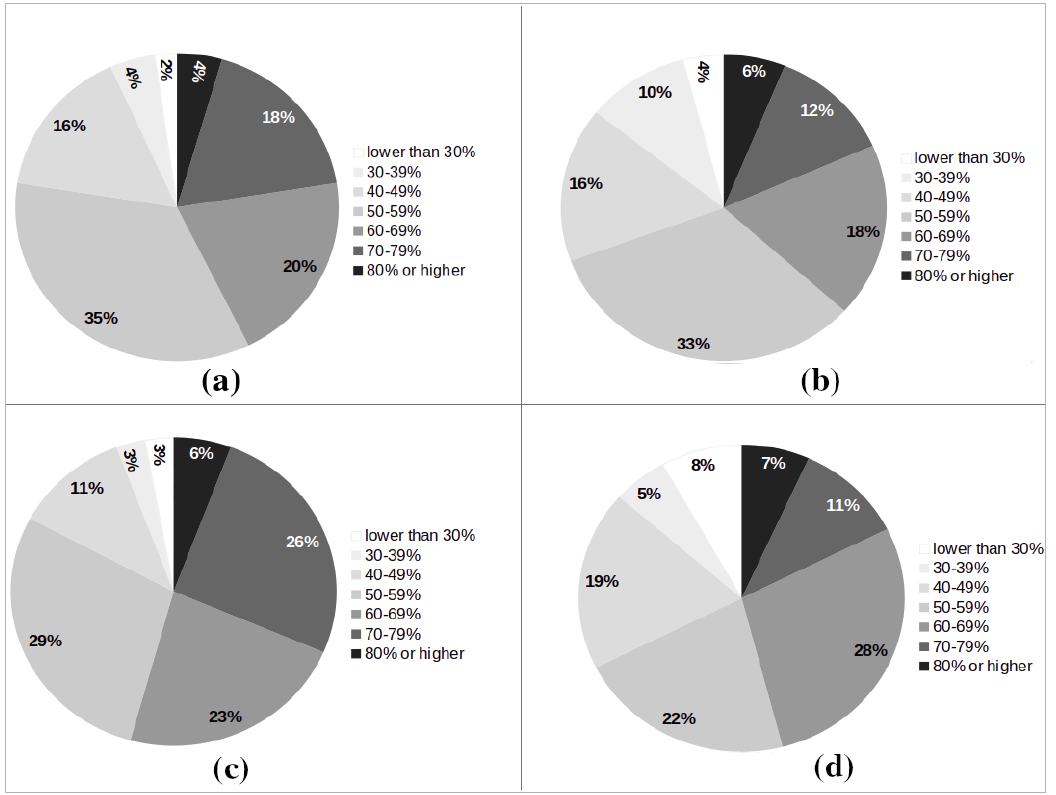
Figure 2. Good practice adoption index (GPAI): Percentage of GPs adopted by producers. ( a ) dairy producers; ( b ) beekeepers; ( c ) vegetable producers; ( d ) berry producers.